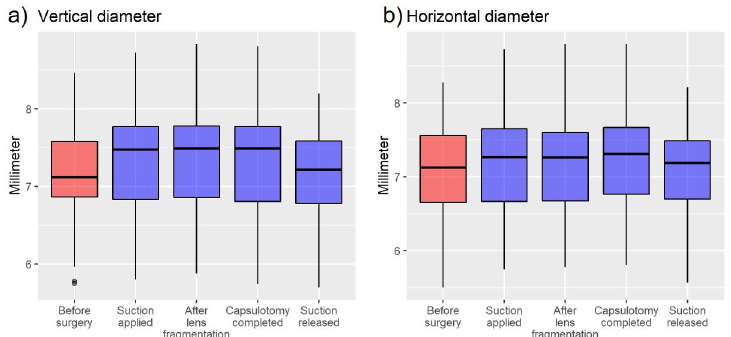
Fig 2. Changes in pupil diameters at different time points of low-energy Femtosecond-Laser-Assisted Cataract Surgery (FLACS) using the Ziemer LDV Z8. Boxplots showing the vertical (a) and horizontal (b) pupil diameters (median, quartiles, minimum, and maximum) before surgery, immediately after application of suction, after completion of lens fragmentation, after completion of laser capsulotomy, and after release of suction.